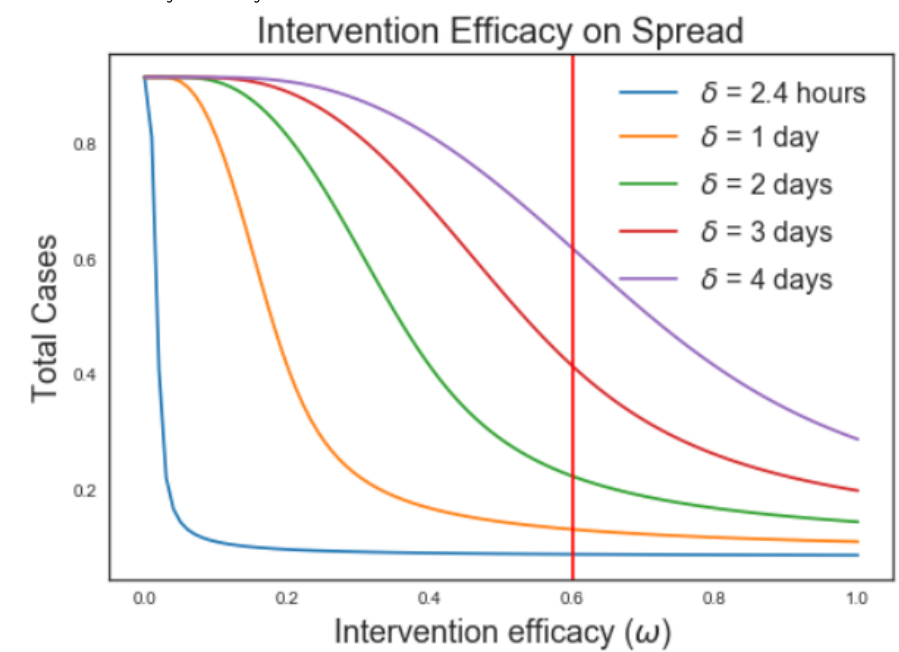
Figure 7. Impact of intervention efficacy and delay time on intervention